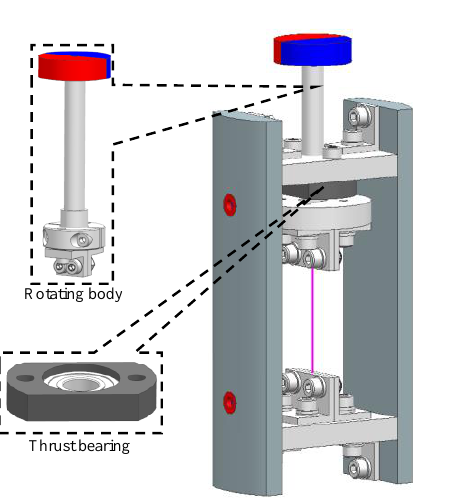
Figure 4. Illustration of the torque application.